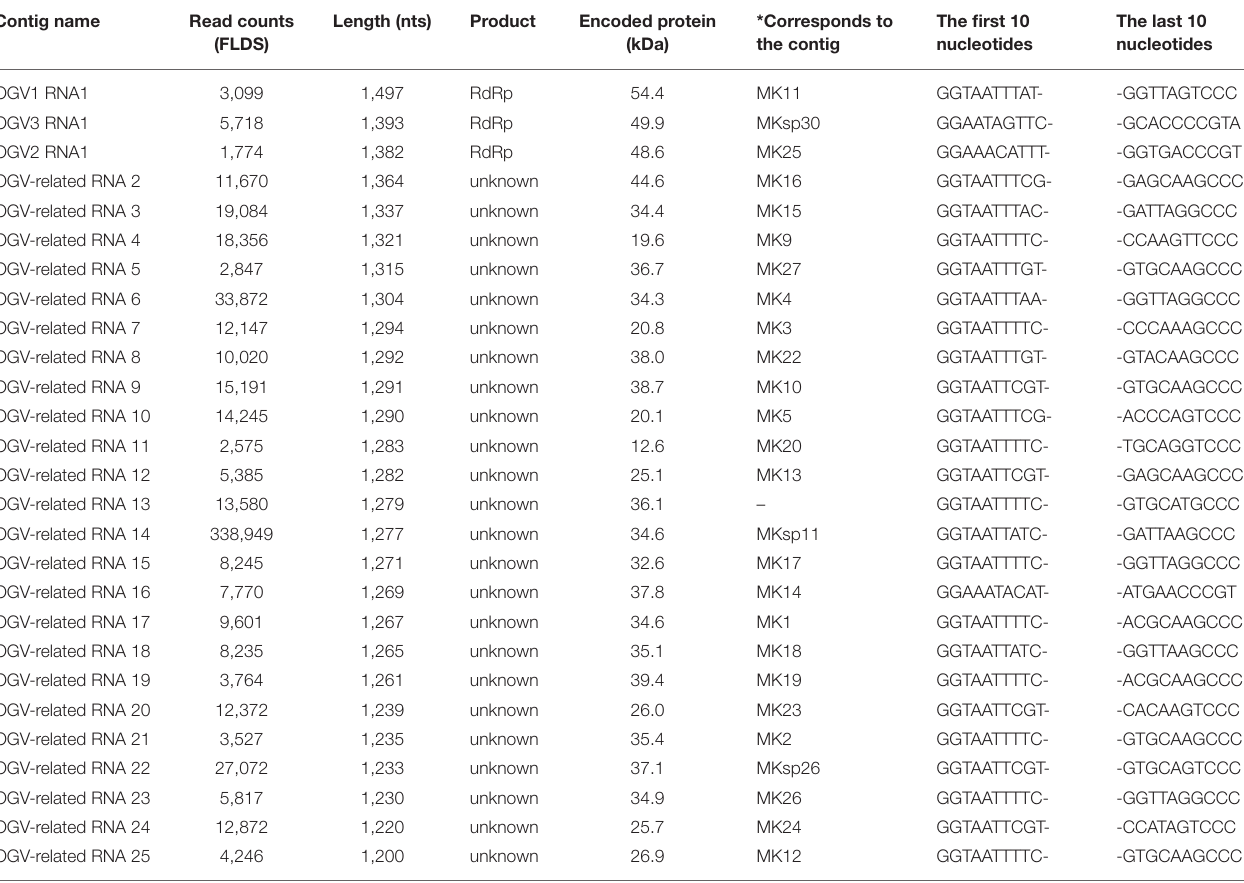
TABLE 2 | Contigs determined in FLDS analysis using purified ds RNA of Homona magnanima late strain.